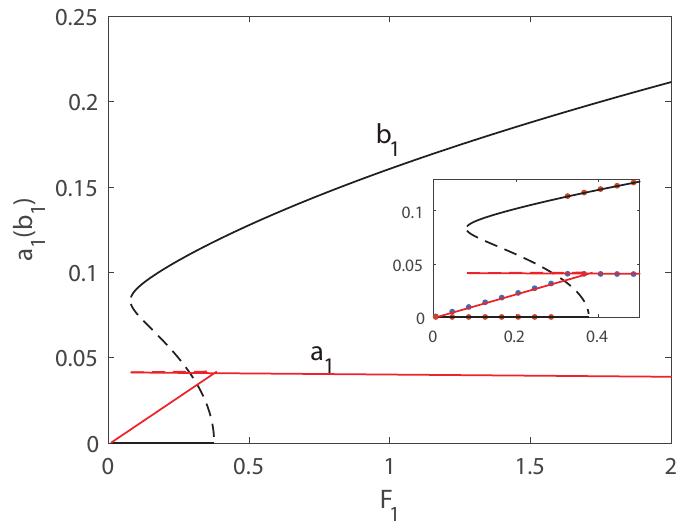
Figure 6. Amplitudes of response as functions of the excitation amplitude F 1 . Line: pseudo-arclength continuation method, Points: long-time-integration